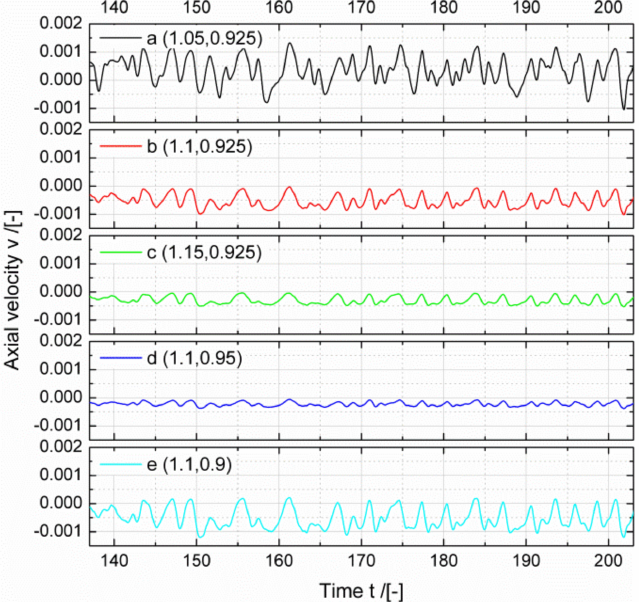
Figure 7. Variation of axial velocity at monitoring points ( Ca C = − 0.01, R = 2.5 mm, H/R = 1.0, Vr =